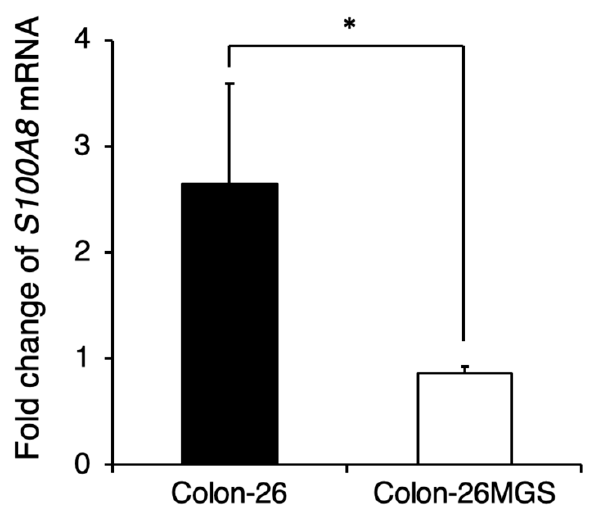
Figure 4. Comparison of pre-metastatic niche preparation between Colon-26MGS and Colon-26. Colon-26 or Colon-26MGS cells were transplanted into the right hind leg, and 17 days later, the lung tissue sample was collected for qRT-PCR. S100A8 mRNA expression in the lung tissue of Colon-26MGS and Colon-26 was evaluated by qRT-PCR. * p < 0.05 by Student’s t-test. Bars indicate standard error calculated using data from three independent trials.